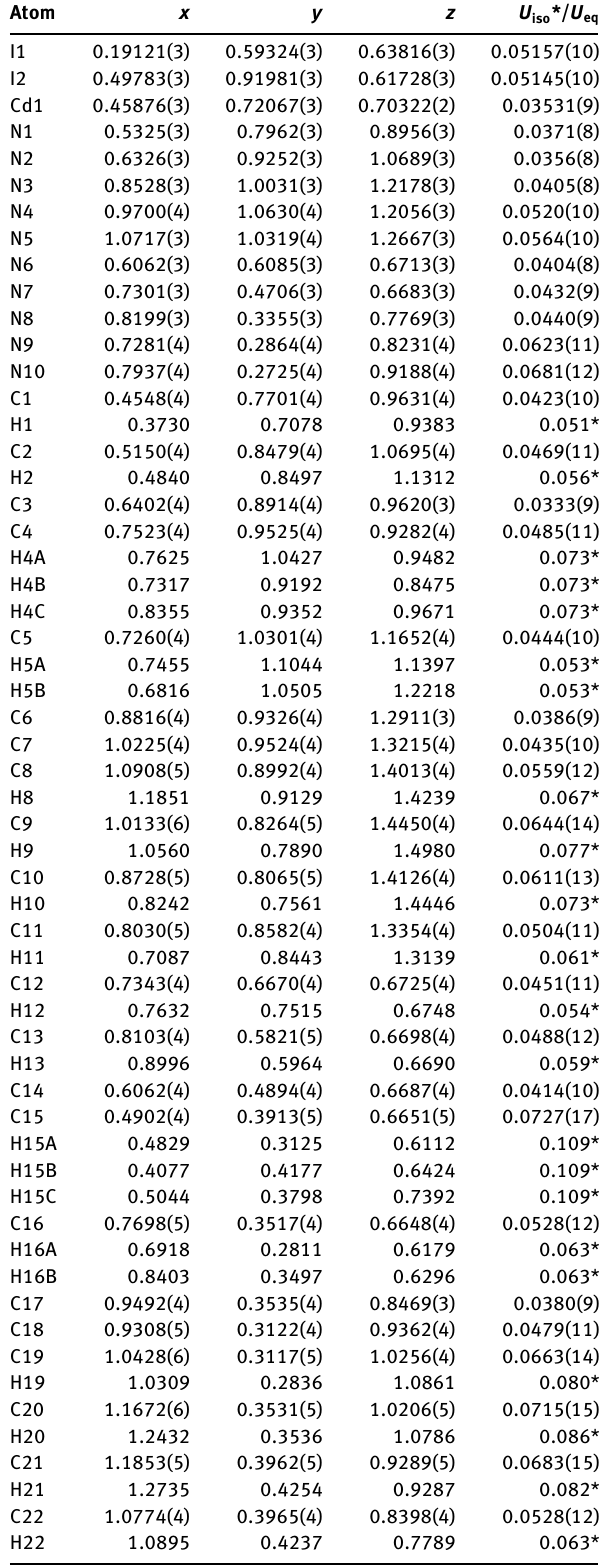
Table 2: Fractional atomic coordinates and isotropic or equivalent isotropic displacement parameters (Å 2